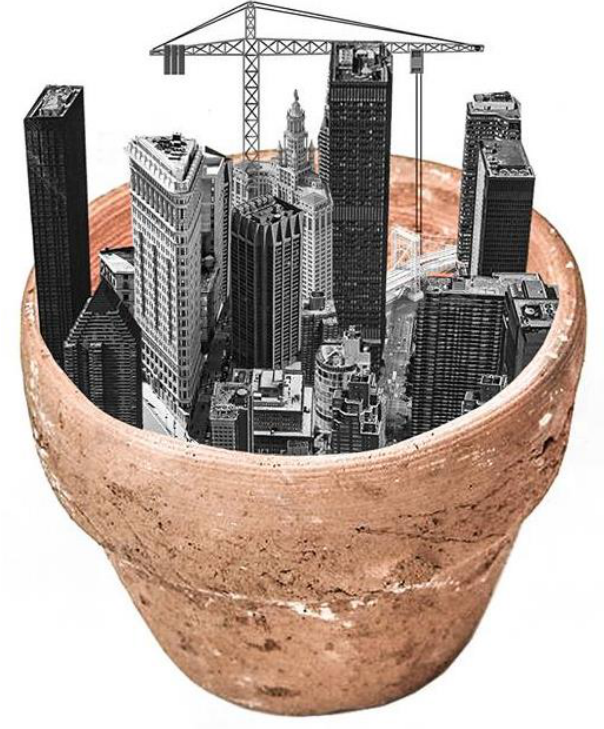
Figure 4. An Urban Area in A Pot, By Serap Sonmez (Sonmez,